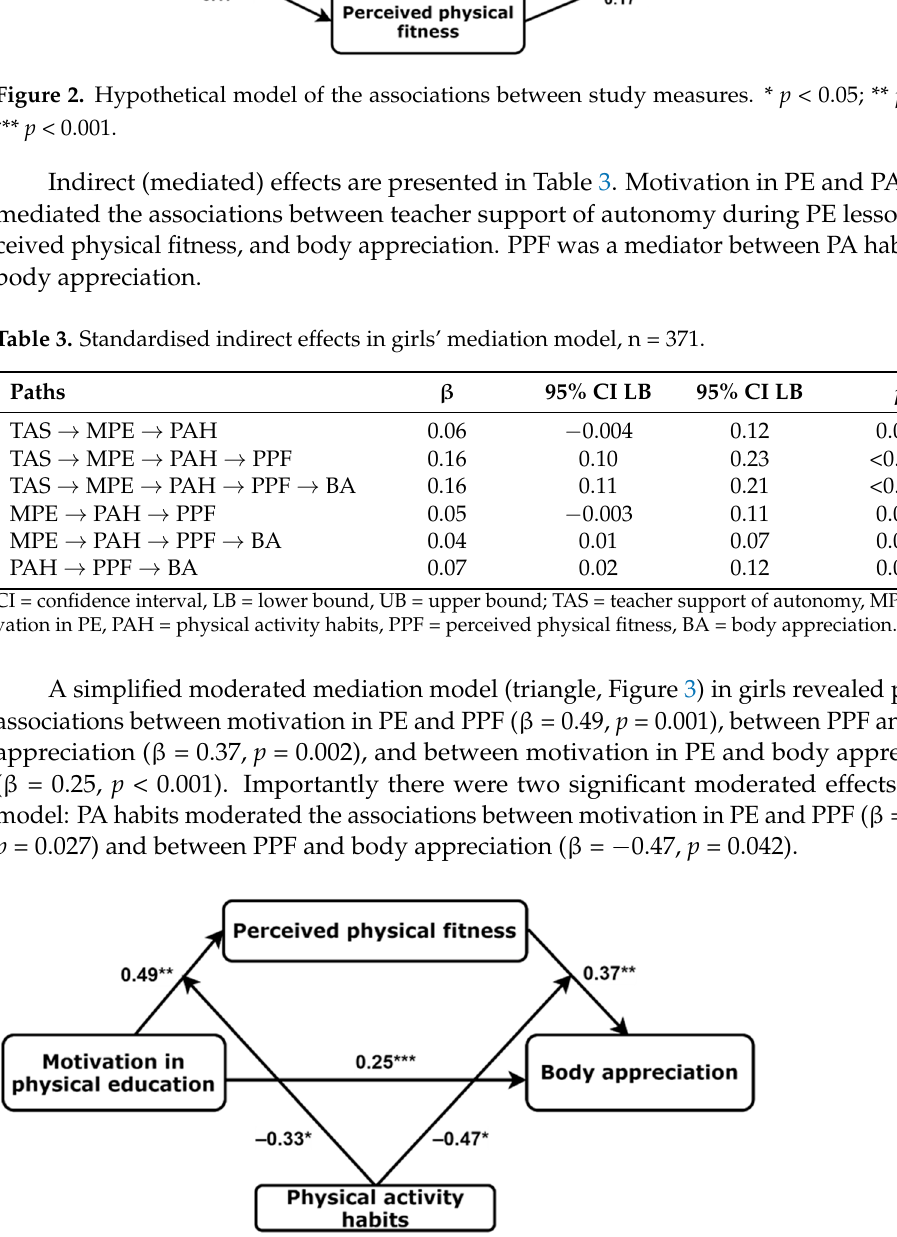
Figure 3. Physical activity habits moderate the associations between motivation in physical education, perceived physical fitness, and body appreciation in adolescent girls (n = 371). * p < 0.05; ** p < 0.01; *** p < 0.001.